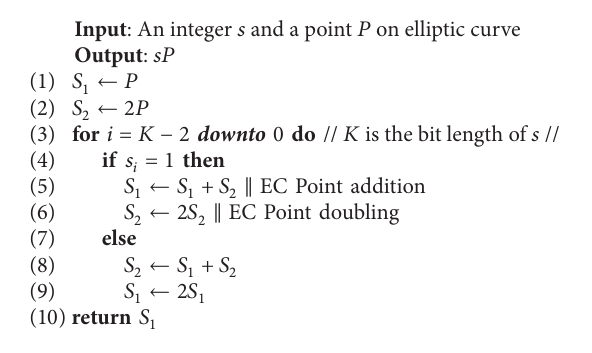
Algorithm 1: Montgomery ladder for EC point multiplication